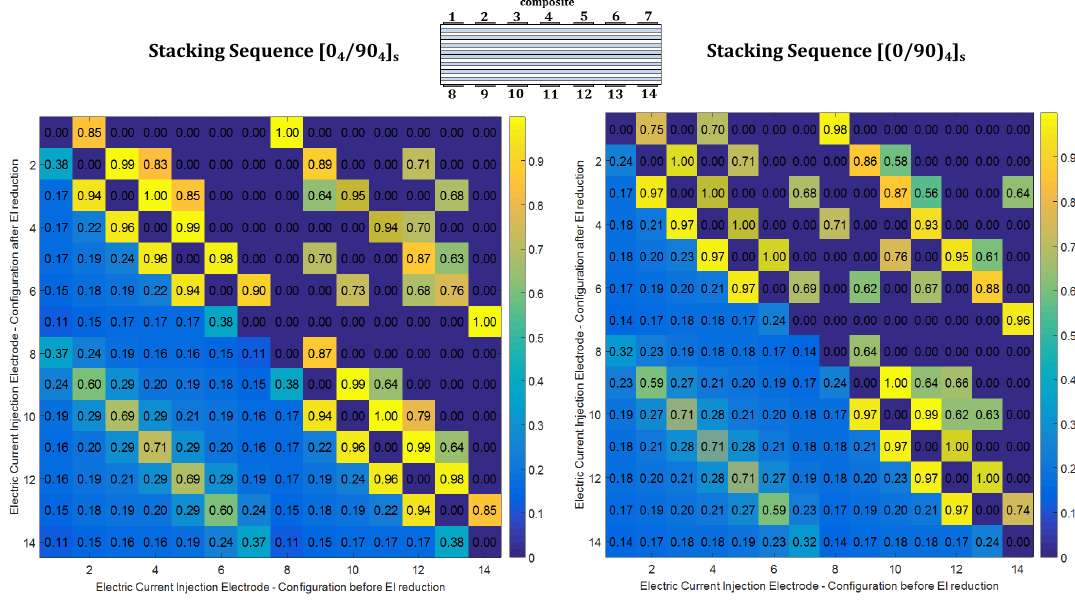
Figure 6. Graphical representation of effective independence values before and after electrode combination reductions for [ 0 4 /90 4 ] s ( left ) and [( 0/90 ) 14 electrodes. (the above diagonal indicates retained